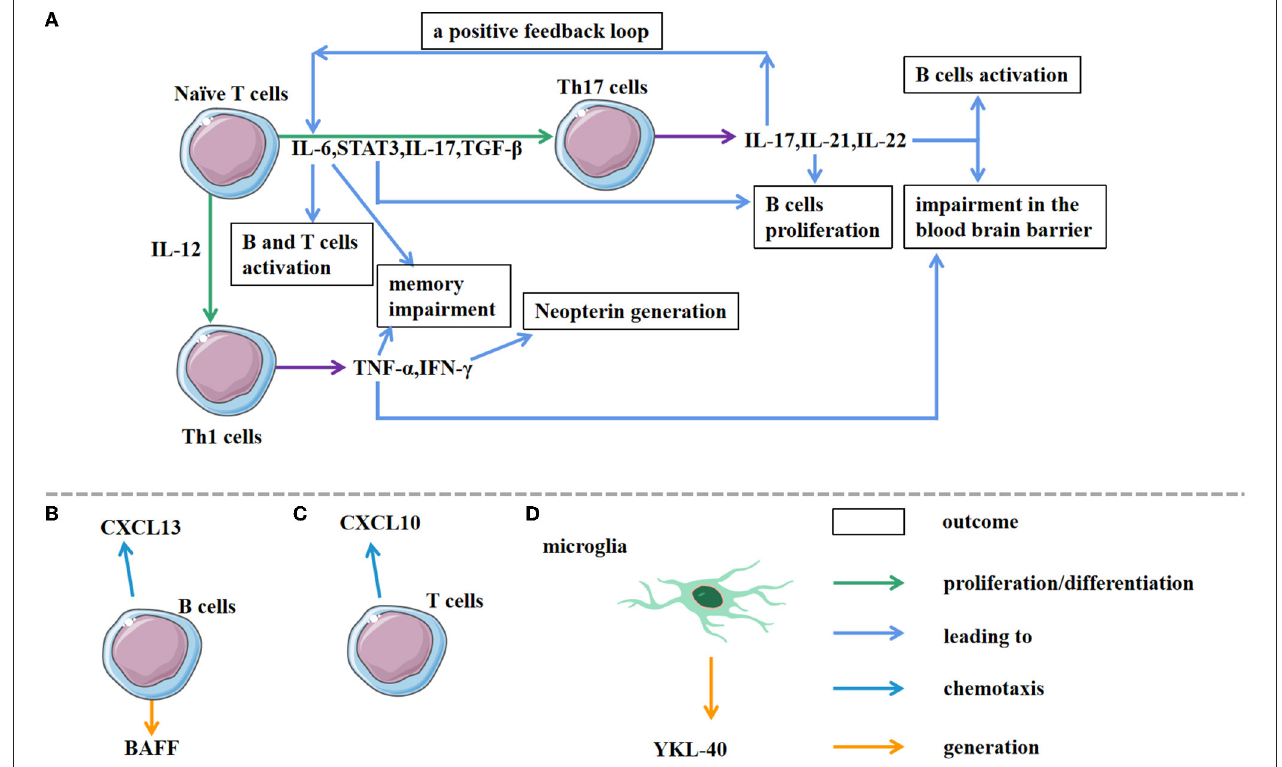
FIGURE 2 | Associated cells involved in AE pathological processes. (A) Under the action of different cytokines, naive T cells differentiate into different Th cells. As a joint result of IL-6, STAT3, IL-17, TGF- β , naive T cells differentiate into Th 17 cells. The subsequent production of IL-17, IL-21, IL-22 by Th 17 cells triggers the immune response and impairs the blood brain barrier. In addition, IL-17A triggers a positive feedback loop of IL-6 signaling, leading to IL-17A/IL-6 co-activation. IL-12 activation can induce Th 1 cell differentiation. Furthermore, Th 1 cells secrete cytokines, such as TNF- α and IFN- γ , resulting in different outcomes. (B,C) As chemokines, CXCL13 and CXCL10 induce directional chemotaxis of B cells and T cells, respectively, towards the target sites. (D) The production of YK-40 by microglia contributes to the early diagnosis.